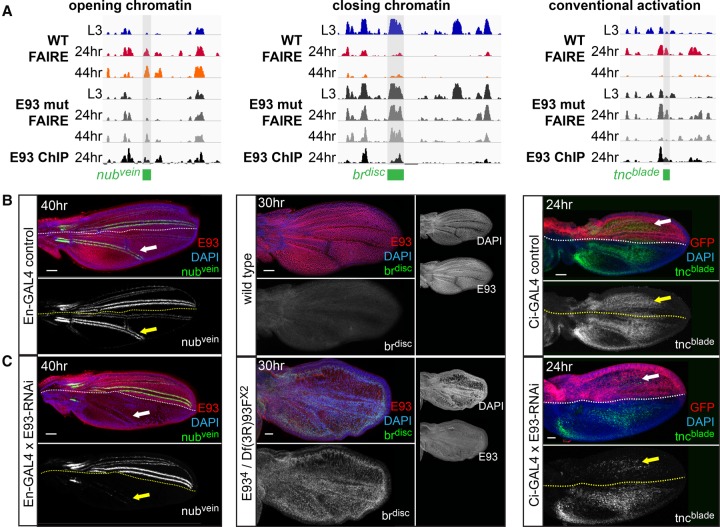
E93 controls temporal-specific enhancer activity through three distinct modalities. (A) Browser shots of FAIRE-seq and ChIP-seq signal from wild-type and E93 mutant wings at the indicated loci. (B,C) Immunostaining of reporter activity for each indicated enhancer. (B) Reporter activity in control or wild-type wings. (C) Reporter activity (green) in wings expressing E93 RNAi under control of Ci-GAL4 (tncblade) or En-GAL4 (nubvein) or in E93 mutant wings (brdisc). The dotted lines indicate the boundary between RNAi-expressing and RNAi-nonexpressing cells. Arrows indicate loss of reporter activity. Bars, 50 µm.